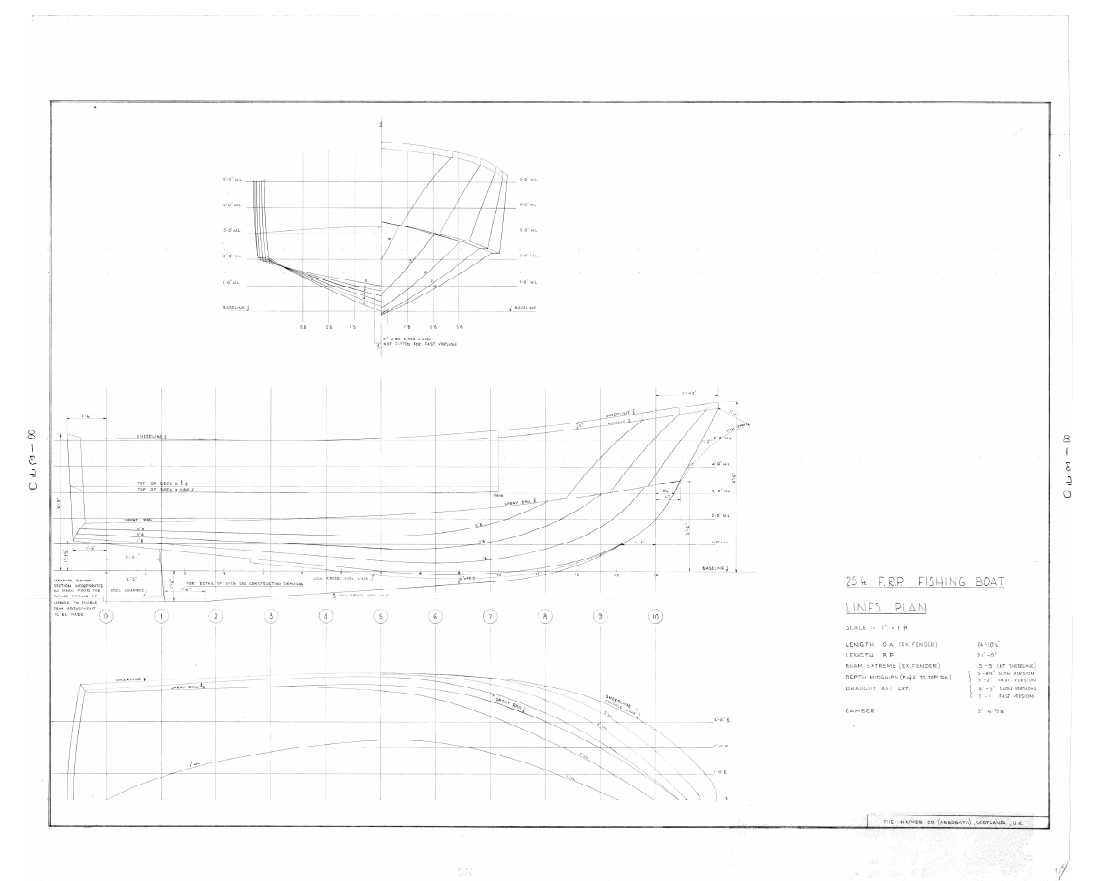
Figure 12. Example 2 line drawings (FAO3), LOA = 7.62 m, BOA = 2.97 m.